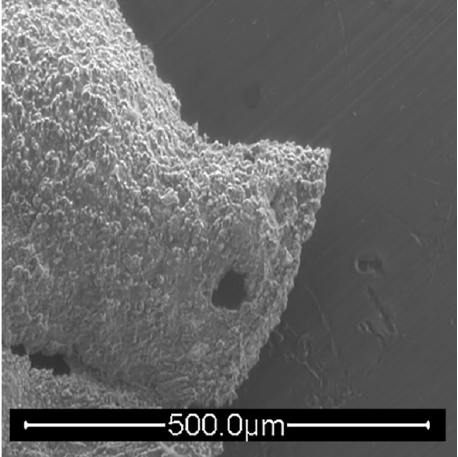
Figure 10. Ceratobairdia sp., right valve, lateral view. IGM 5011(6). Scanning electron micrograph (secondary electrons). Detail of anterior corner spine. Scale bar = 500 microns.